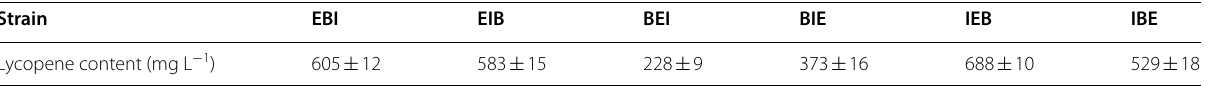
The strains are named according to the gene order of E: crtE, B: crtB , and I: crtI